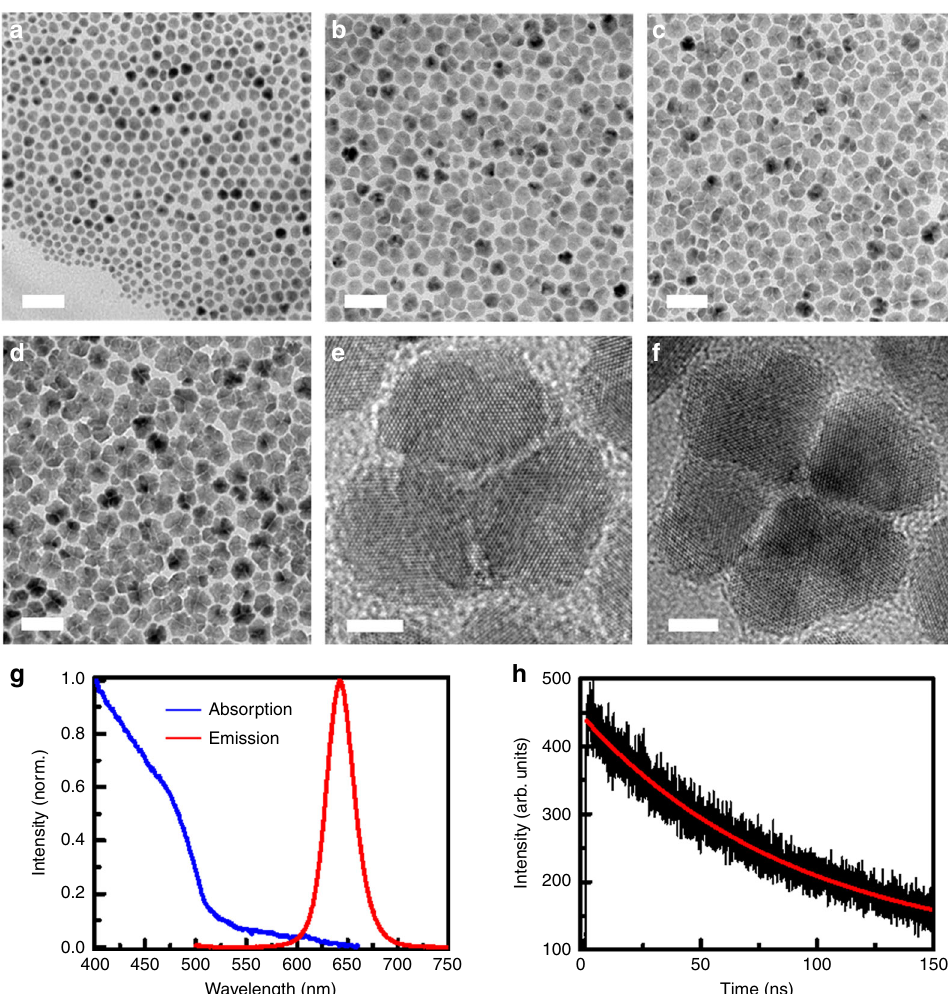
Fig. 1 Structural images and ensemble optical properties of gNCCs. a , b , c , d TEM (transmission electron microscopy) images showing the formation of CdSe/CdS gNCCs with the CdS shell thicknesses of 5, 10, 15, and 20 MLs, respectively. e , f High-resolution TEM images of two single CdSe/CdS gNCCs. g Absorption and emission spectra of ensemble CdSe/CdS gNCCs. h Photoluminescence (PL) decay curve of ensemble CdSe/CdS gNCCs fi tted with a single-exponential lifetime of 93.1 ns. The optical measurements in ( g ) and ( h ) were performed at room temperature. The scale bars used in ( a – d ) represent 50 nm, while those in ( e ) and ( f ) represent 5